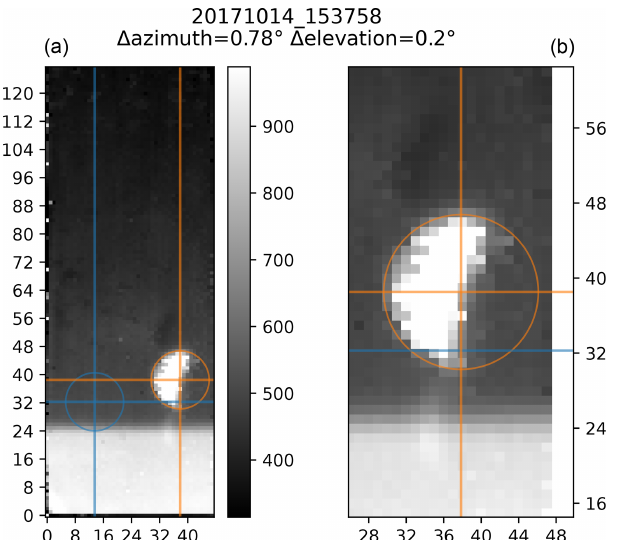
Figure 14. Example of the determination of the position of the moon for one cube measured on 14 October 2017 at 15:37:58Z. Panel (a) shows the full image, while panel (b) shows the moon in an enlarged fashion. The expected position of the moon is shown in blue; the manually determined actual one is in orange. Here, the difference between the expected and actual positions of the moon is 0.78 ◦ horizontally and 0.2 ◦ vertically.